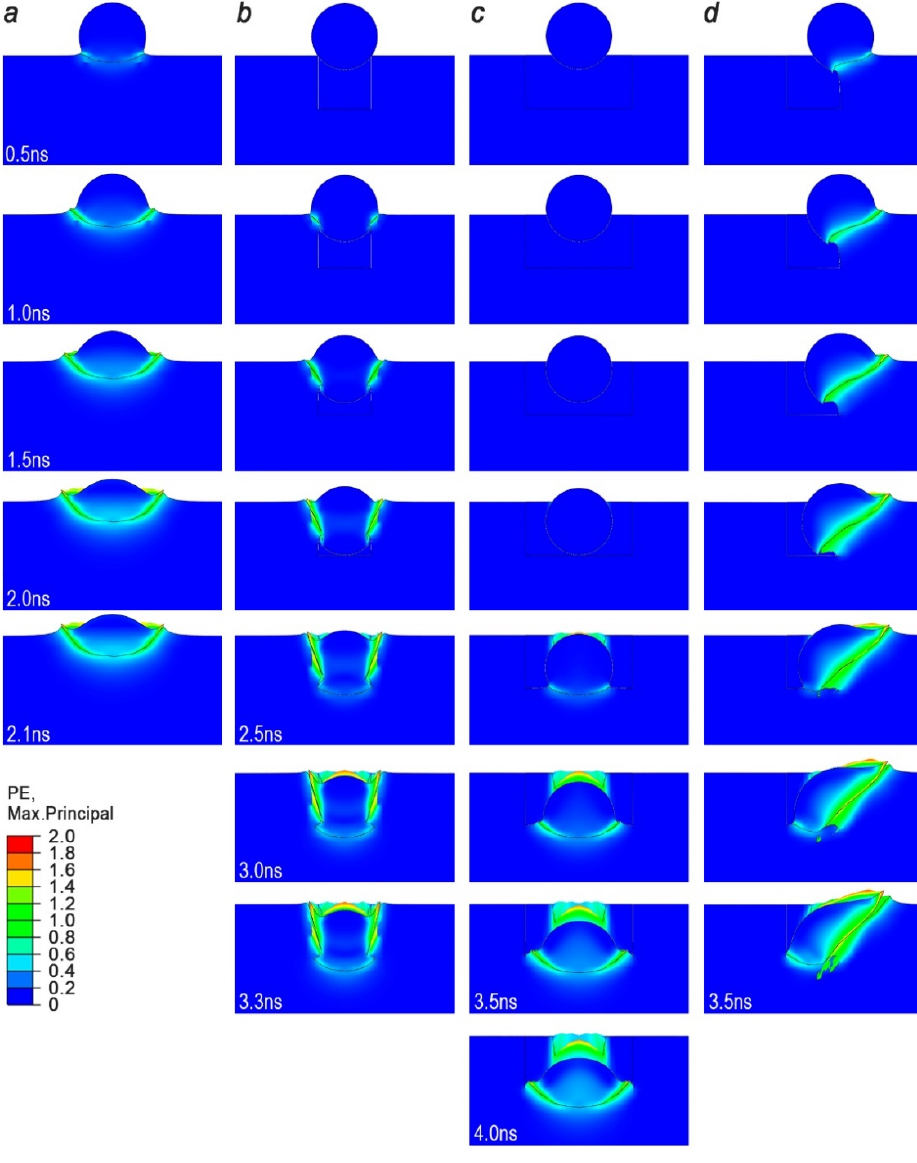
Figure 8. Plastic strain of the particle ( d P = 2.1 µ m) and the substrate at different time points of the collision: ( a ) without microdefect; ( b ) with cube-shaped microdefect; ( c ) with rectangular-shaped microdefect; ( d ) with the particle collision on the edge of cube-shaped microdefect.